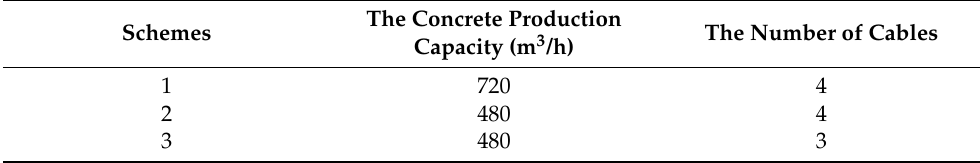
Table 4. Construction resource investment of the arch dam construction schemes.